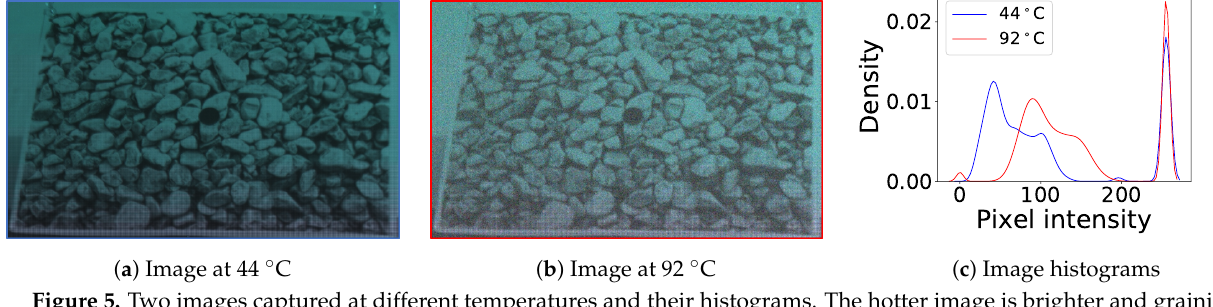
Figure 5. Two images captured at different temperatures and their histograms. The hotter image is brighter and grainier, due to the influence of thermal noise. This is also reflected in the shift in mean and